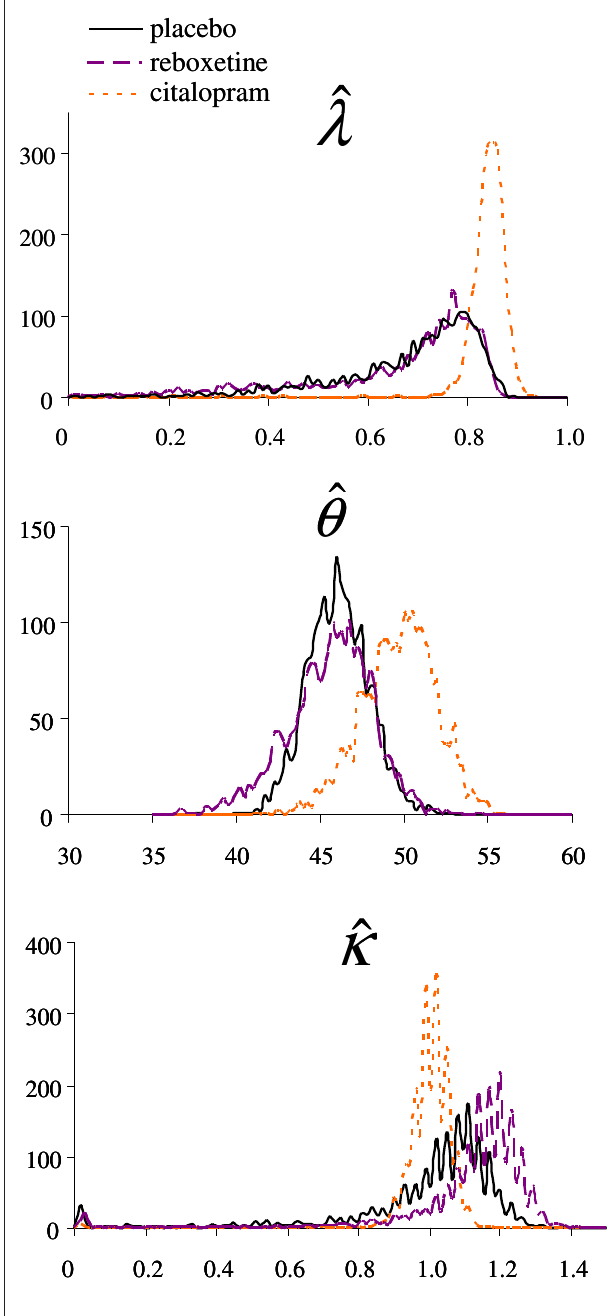
Figure S2 | Bootstrap distributions of the ˆ λ (decay parameter; larger values indicate slower decay rate), ˆ θ (decay center), and ˆ κ (learning rate) parameters in each treatment